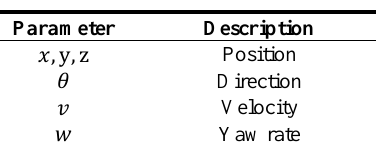
Table 4. Kalman filter state